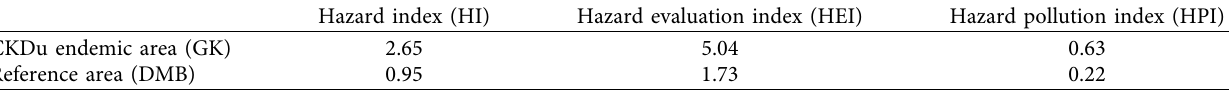
Table 7: The estimated hazard index (HI), hazard evaluation index (HEI), and hazard pollution index (HPI) values for the drinking water samples collected from CKDu endemic and reference areas, Sri